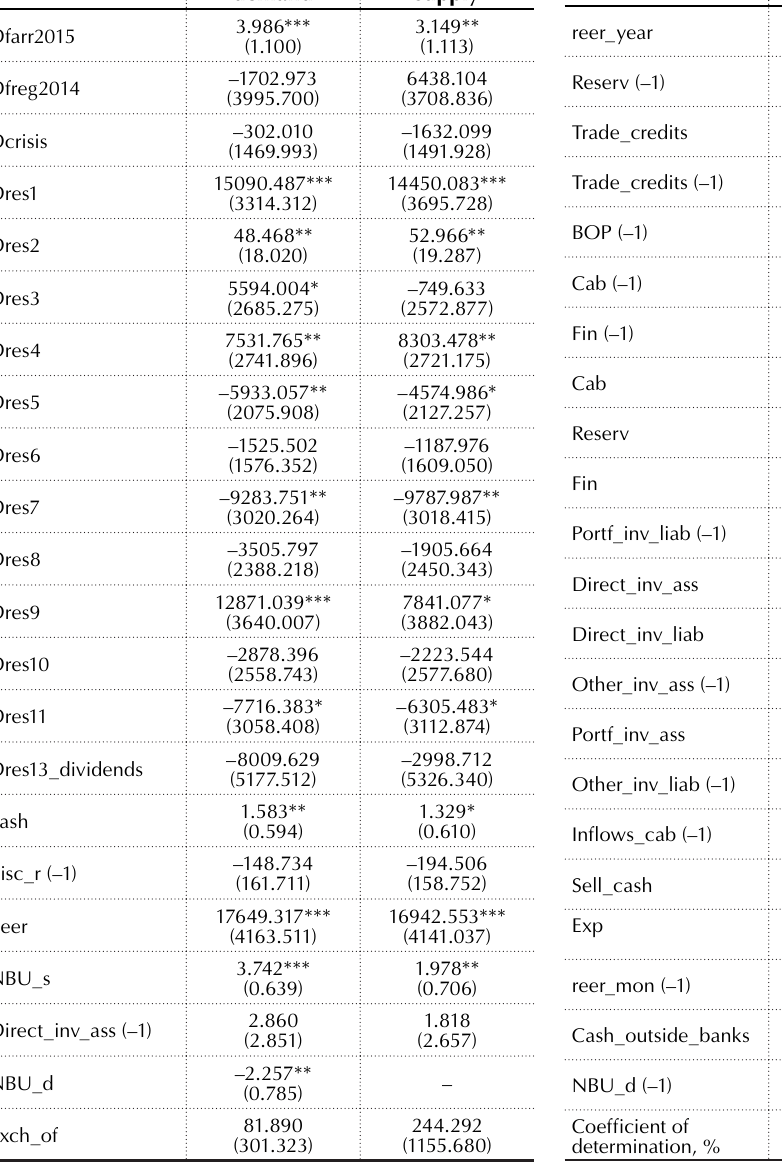
Table 3. Properties of demand-supply model on non-cash foreign exchange currency in Ukraine